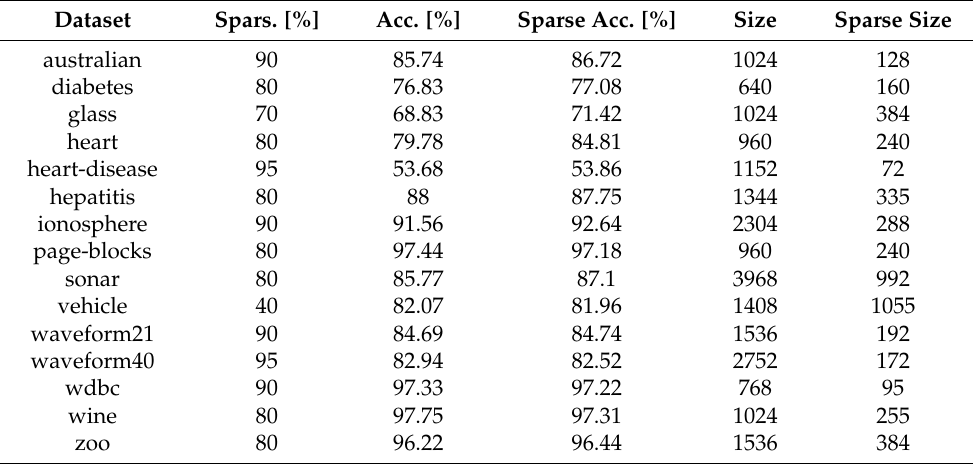
Table 4. Sparse ANN predictive model characteristics.